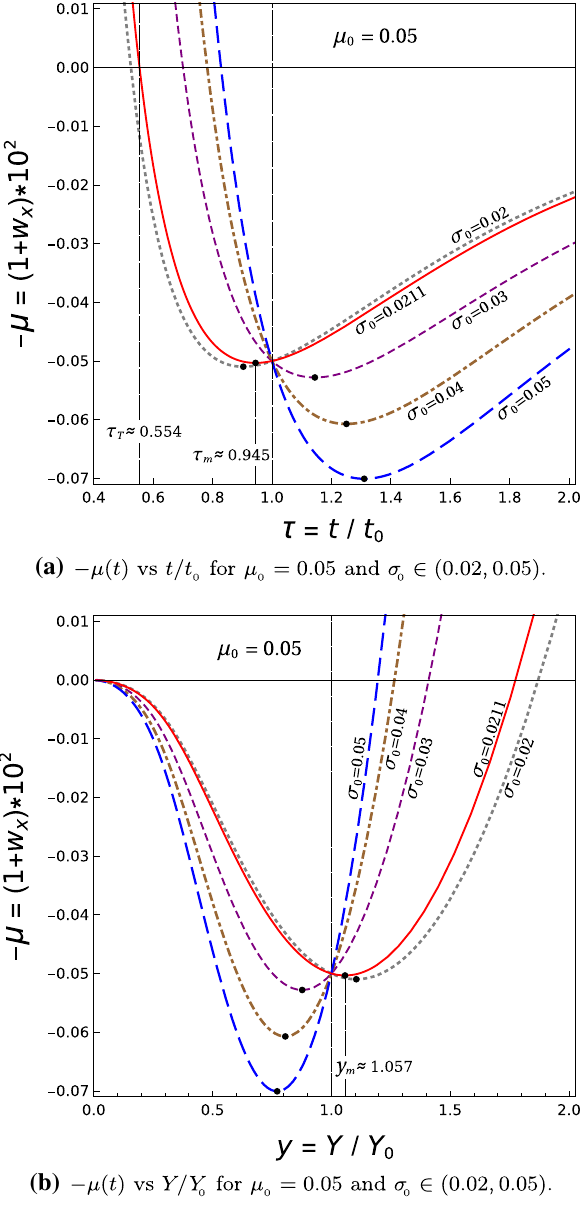
Fig. 2 Variation of the percentage change in the effective DE equa- ) , with a the rationalized cosmic time tion of state: − μ = 100 ( 1 + w X τ = t / t , and b the rationalized correction y = Y / Y in the MMT 0 0 = 0 . 05 and discrete values of potential, for a fixed parametric value μ 0 ∈ ( 0 . 02 , 0 . 05 ) . The thick dots indicate the minima of the parameter σ 0 the plots T μ and A μ . With the MMT coupling function β(φ) given by Eq.(2.19), and the identification s γ 2 = φ ≡ t ,